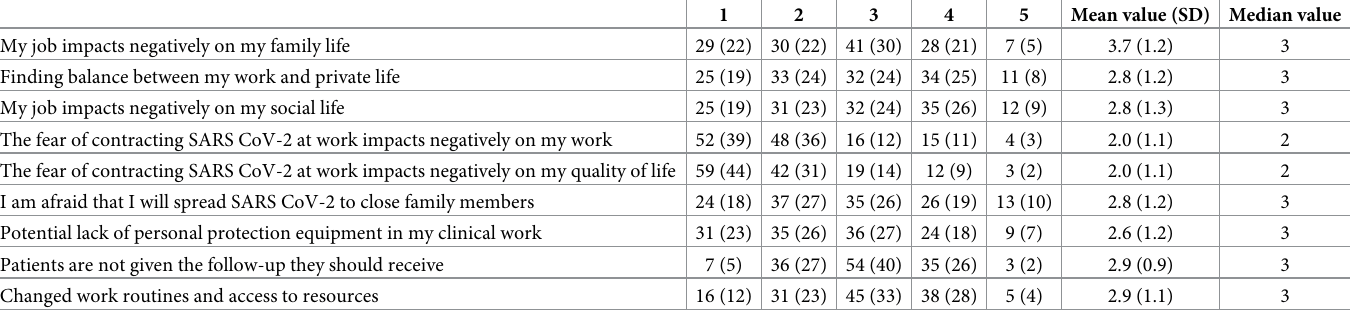
The mean score (SD) of work-home interface stress was 2.8 (1.1) for the total sample with no significant differences between female (2.9 (1.1)) and male (2.6 (1.1)) or between residents (2.9 (1.0)) and senior consultants (2.6 (1.2)). Depressive thoughts were associated with signifi- cantly higher work-home interface stress (3.4 vs. 2.6, p = 0.005). Self-reported sleep